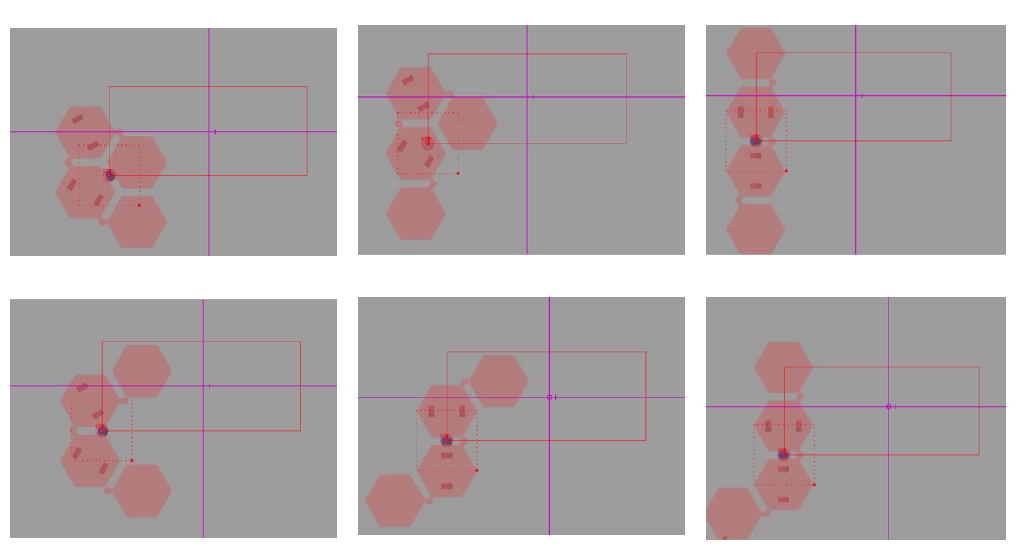
Figure 9. The mobility of platform in the simscape simulation environment. Table 2. Platform velocity ( v x , v y and v θ ) for a set of wheel velocities ( ˙ φ 1 , ˙ φ 2 , ˙ φ 3 , ˙ φ 4 ).